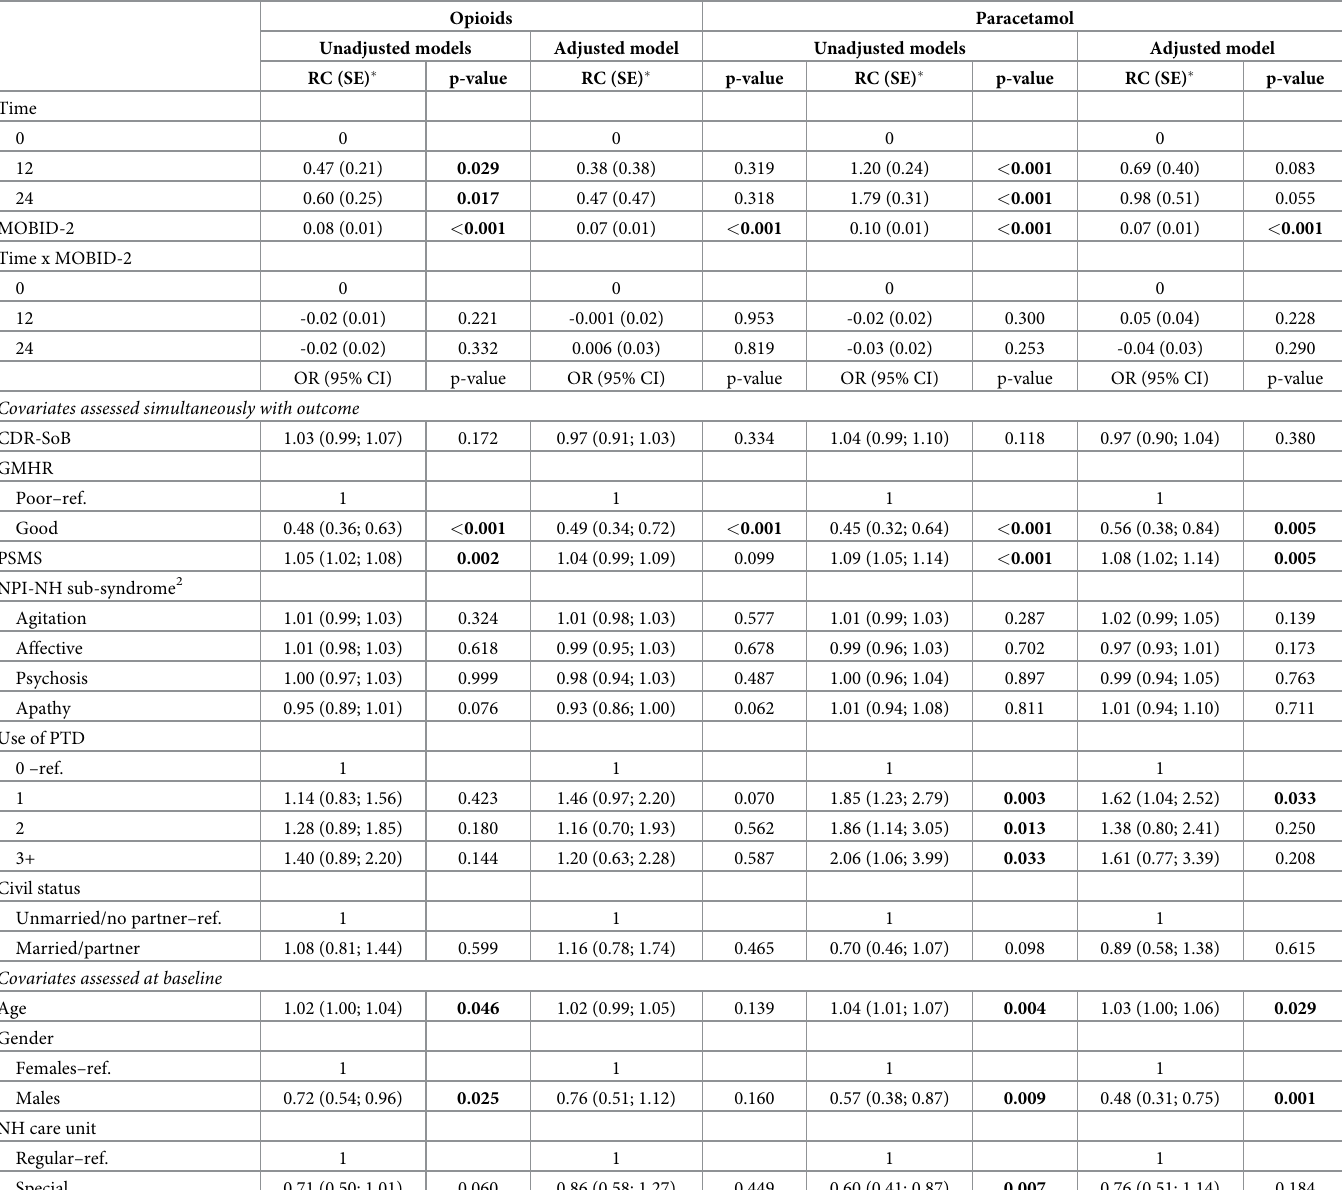
Table 5. Factors associated with prescription of analgesics. Results of generalized linear mixed model 1 (N =